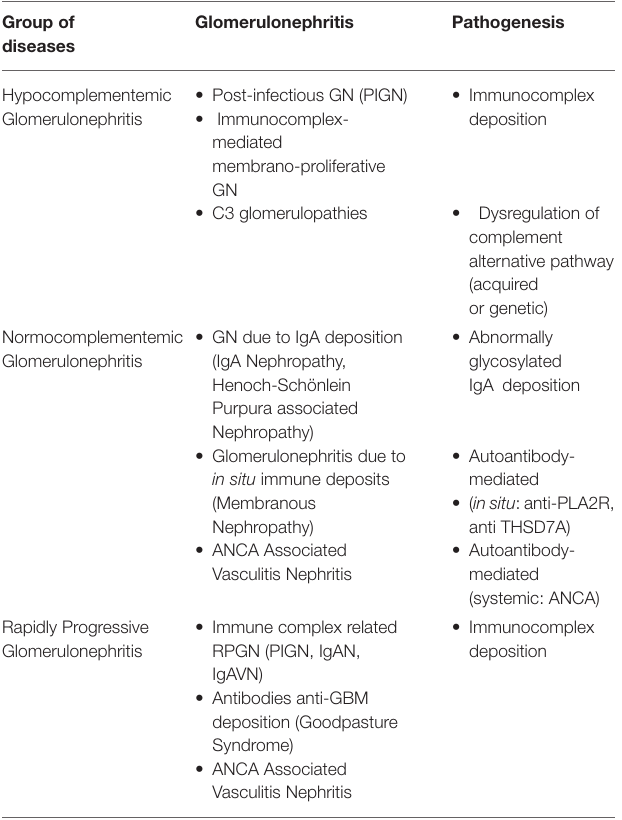
TABLE 1 | Classification of primitive glomerulonephritis underlying the pathogenetic mechanism. Group of diseases